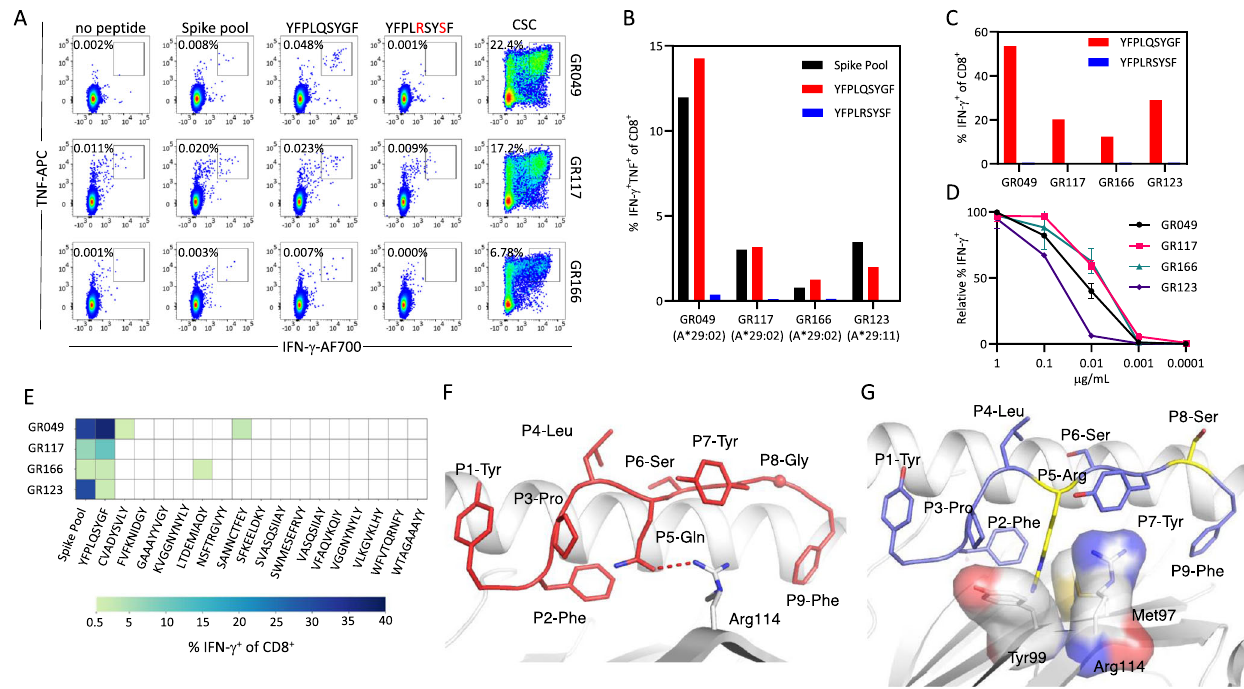
Fig.2|RecognitionoftheimmunodominantHLA-A*29:02-restrictedepitopein vaccinated participants. A Flow cytometry plots displaying the frequency of IFN- γ -producing CD8 + T cells from PBMC of vaccinated HLAA*29:02 + individuals. B Frequency of IFN- γ -producing CD8 + T cells following in vitro culture of PBMC from four vaccinated individuals (A*29:02 n =3; A*29:11 n =1) with spike over- lapping peptide pools. C Frequency of IFN- γ -producing CD8 + T cells following in vitro stimulation with either YFPLQSYGF or YFPLRSYSF and recall with cognate peptide. D FrequencyofIFN- γ -producingCD8 + Tcellsinresponsetoserialdilutions of YFPLQSYGF. Data represents mean and standard deviation of duplicates. E Heatmap of frequency of IFN- γ -producing CD8 + T cells of spike peptide pool,